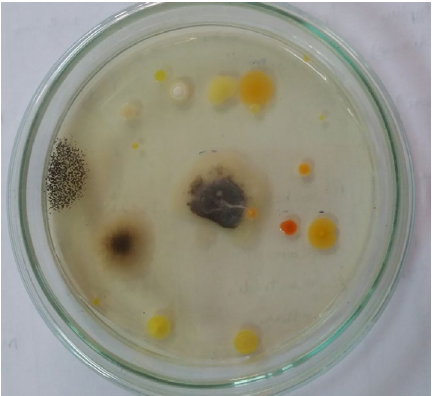
Fig. 2. Subculture of pigmented